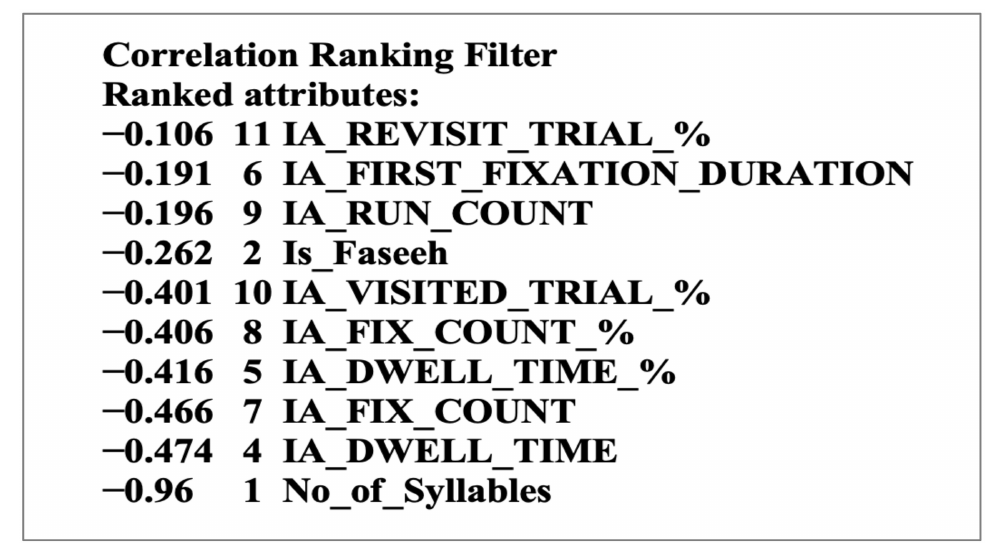
Figure 4. Correlation ranking attribute evaluation (with eye data).